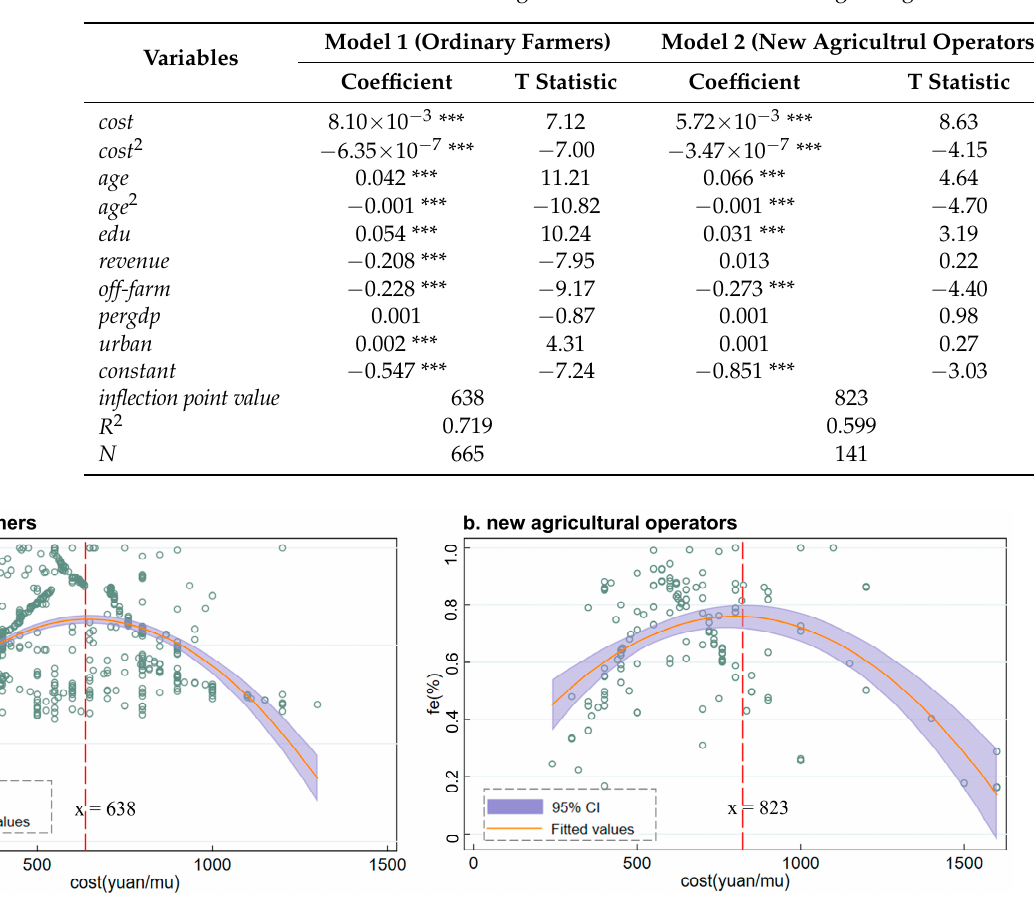
Table 4. Model estimation results of different growers Note: *** denotes reaching 1% significance levels.